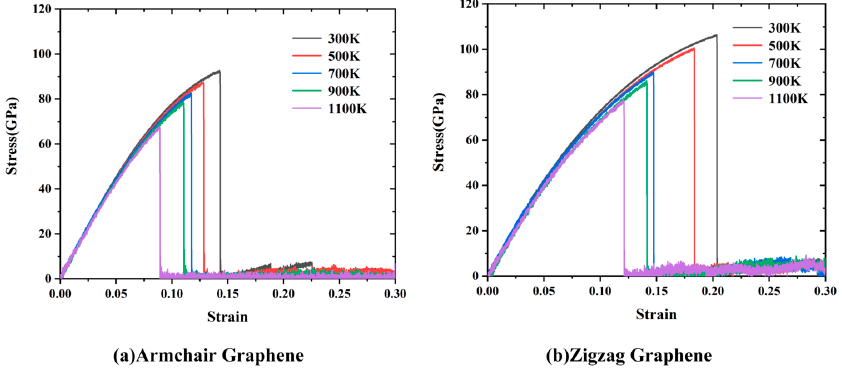
Figure 6. The stress–strain curves of Gr at different temperature along: ( a ) armchair; and ( b ) zigzag.